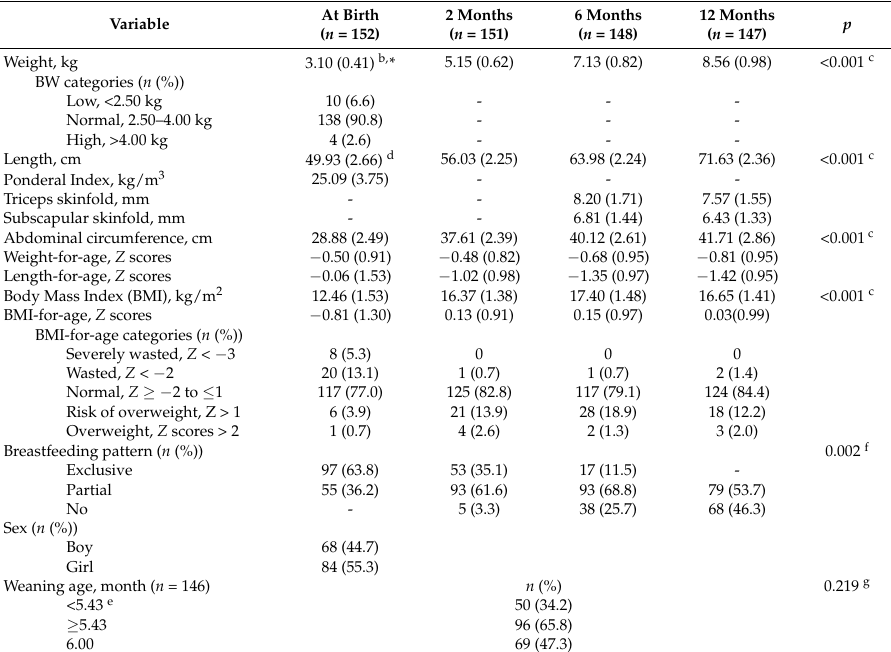
Table 2. Infant characteristics a